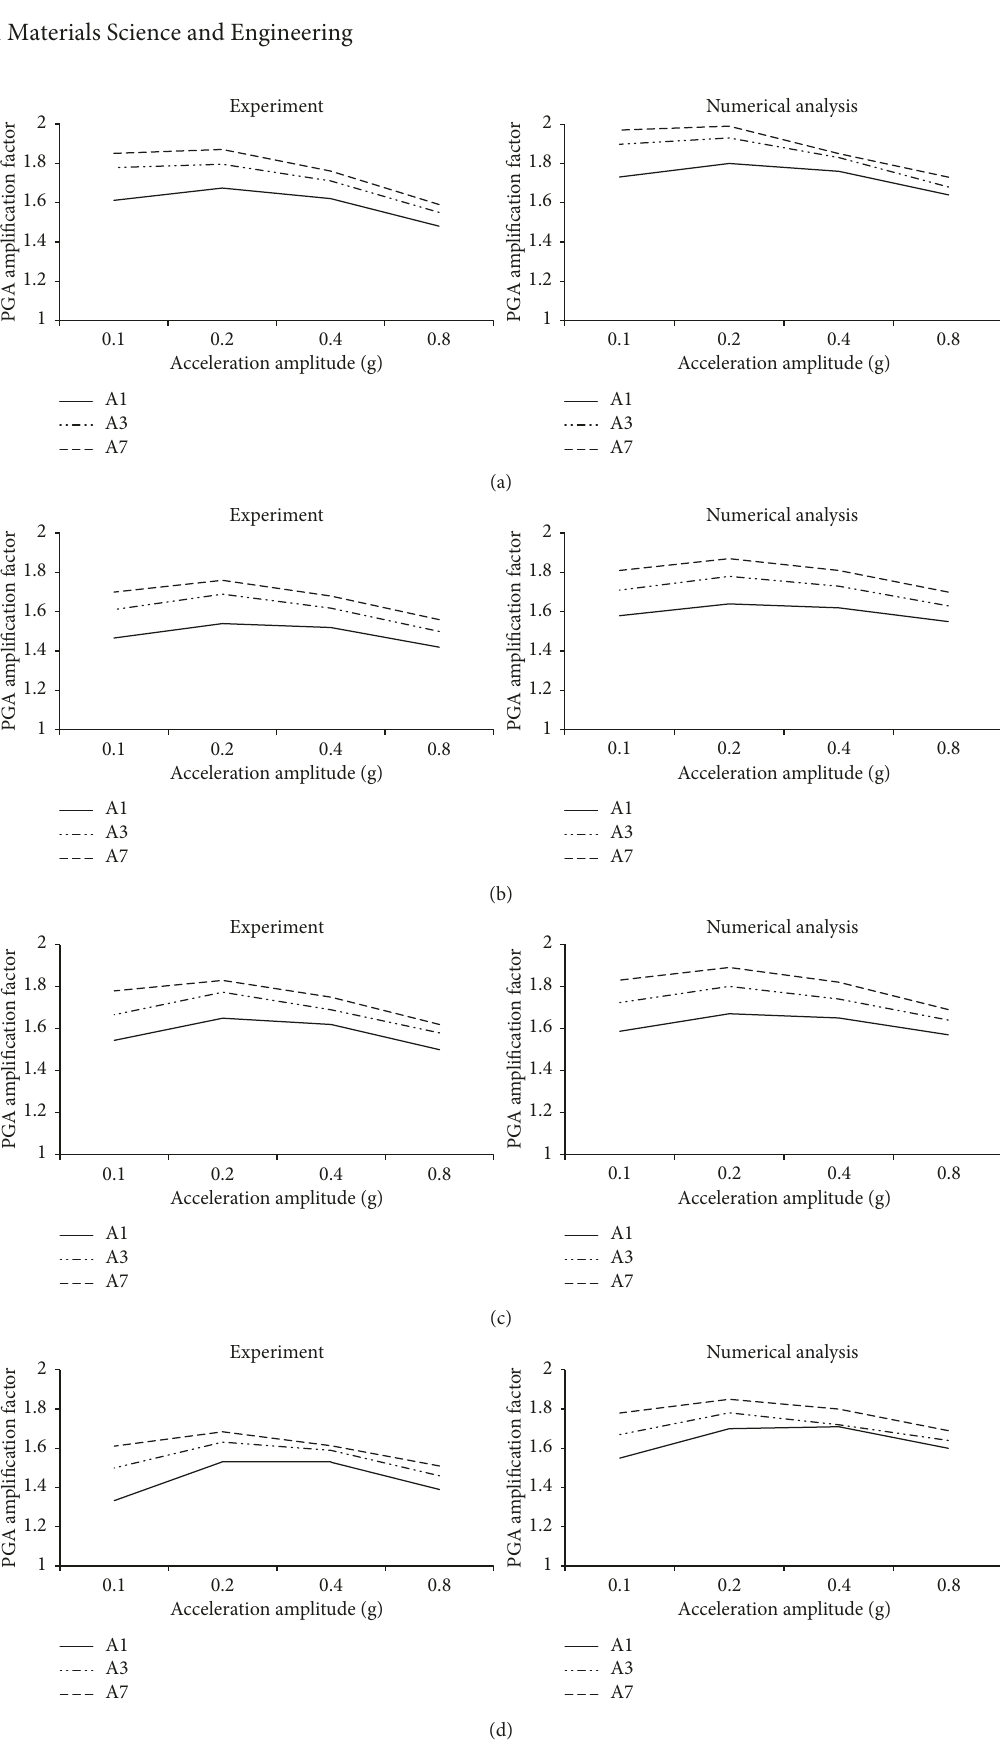
Figure 6: PGA amplification factor-acceleration amplitude curves for slope models. (a) Natural slope without vegetation. (b) Hinged block of slope. (c) Hinged block of ecological slope. (d) Anchor + hinged block ecological